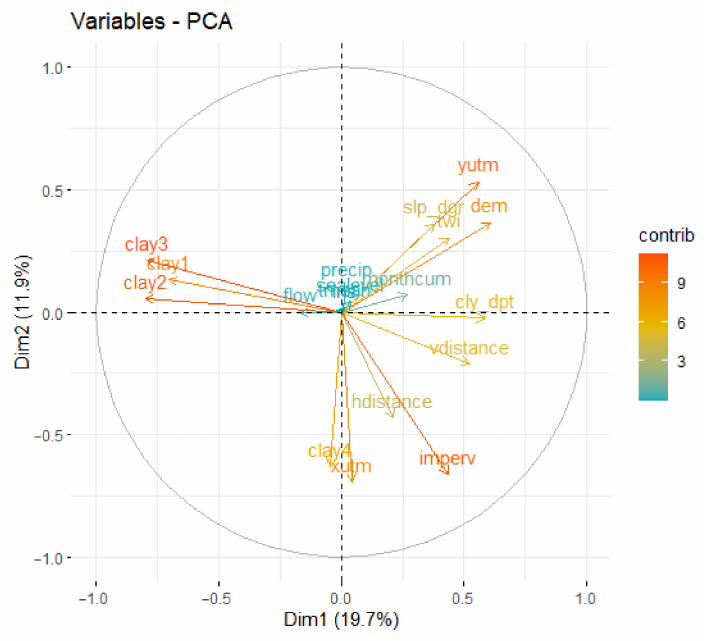
Figure 3. Results from the PCA. Contribution of each variable to the first and second